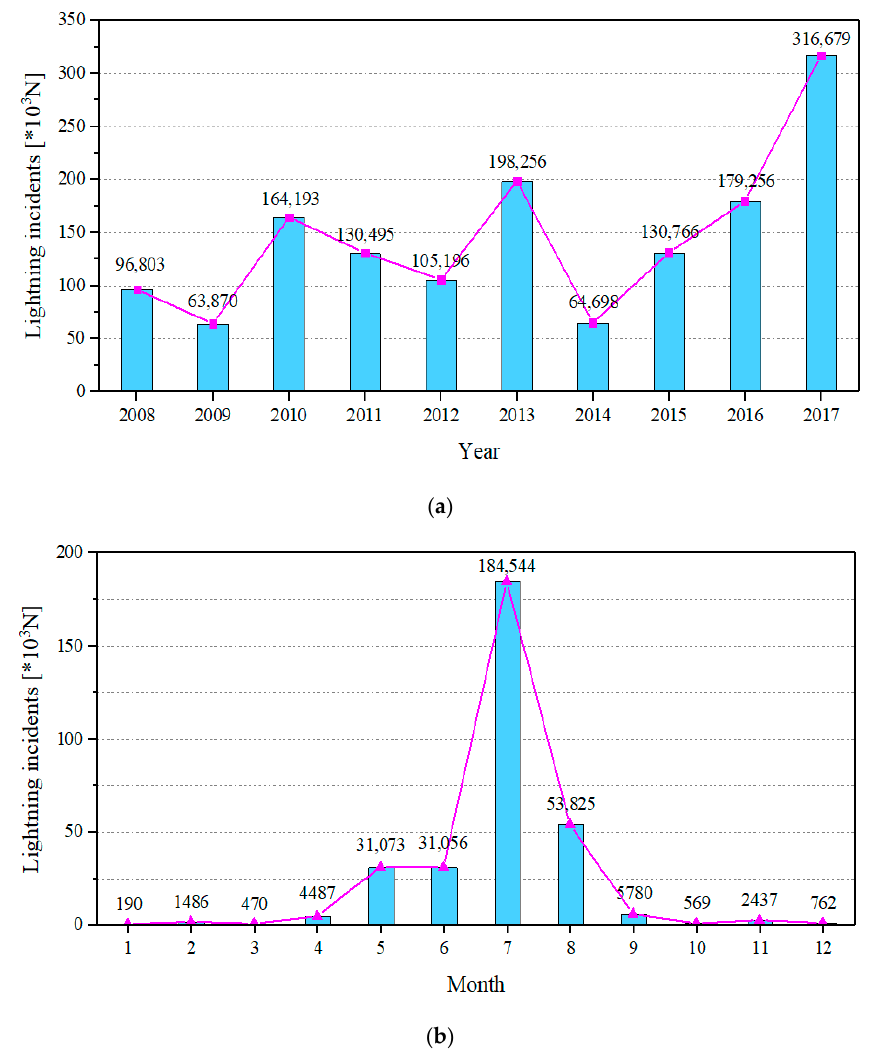
Figure 1. Lightning incidents in South Korea. ( a ) Number of lightning strikes in 2008–2017; ( b ) number of lightning strikes every month in 2017.